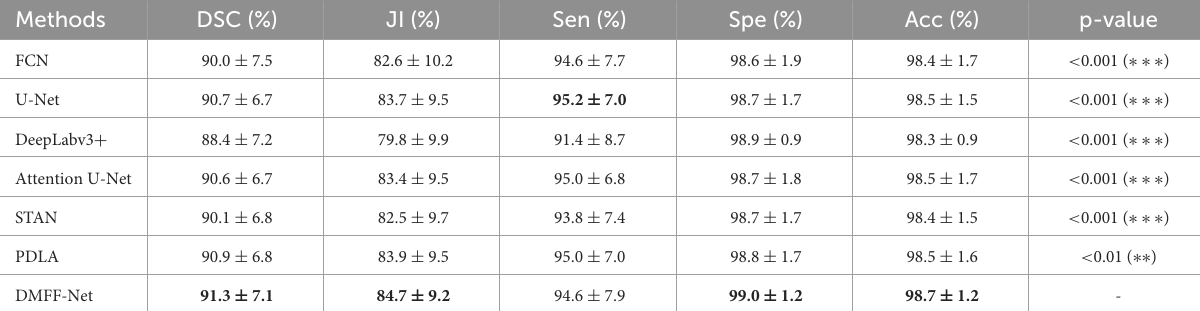
TABLE 6 Quantitative comparison of liver segmentation results between DMFF-Net and other medical image segmentation